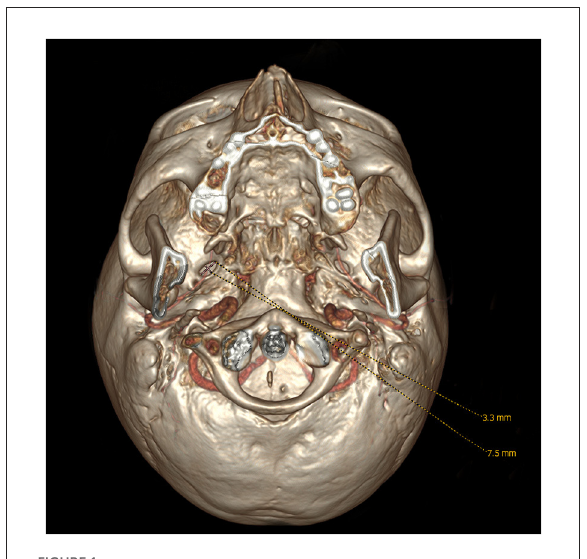
FIGURE1 Observation and measurement of the length and width of the foramen ovale from the bottom on 3D reconstruction